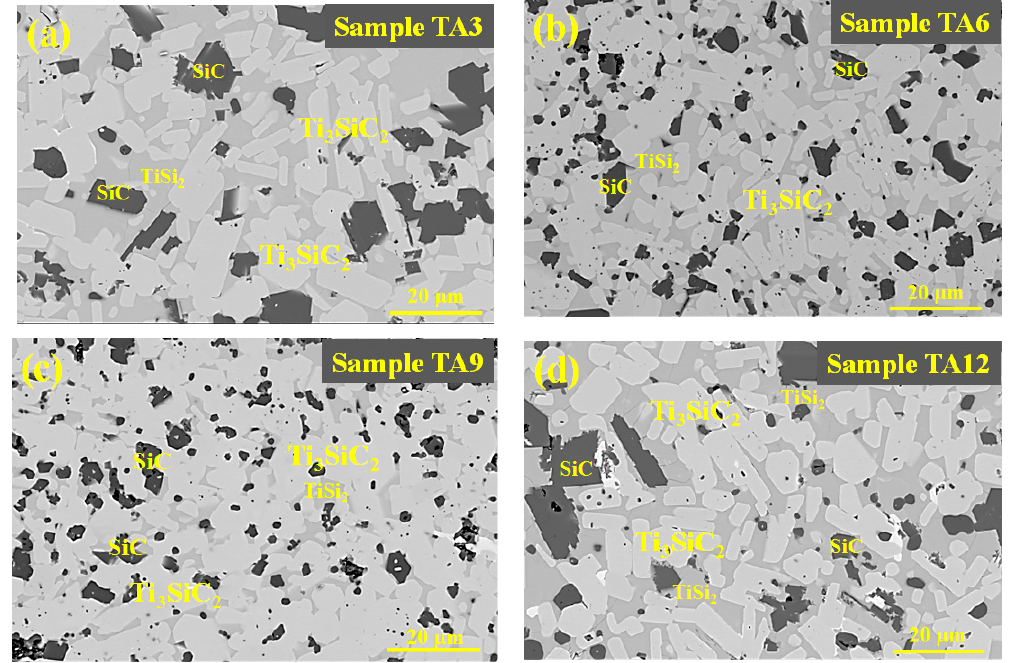
Figure 4. BSE images of samples ( a ) TA3, ( b ) TA6, ( c ) TA9, and ( d ) TA12.